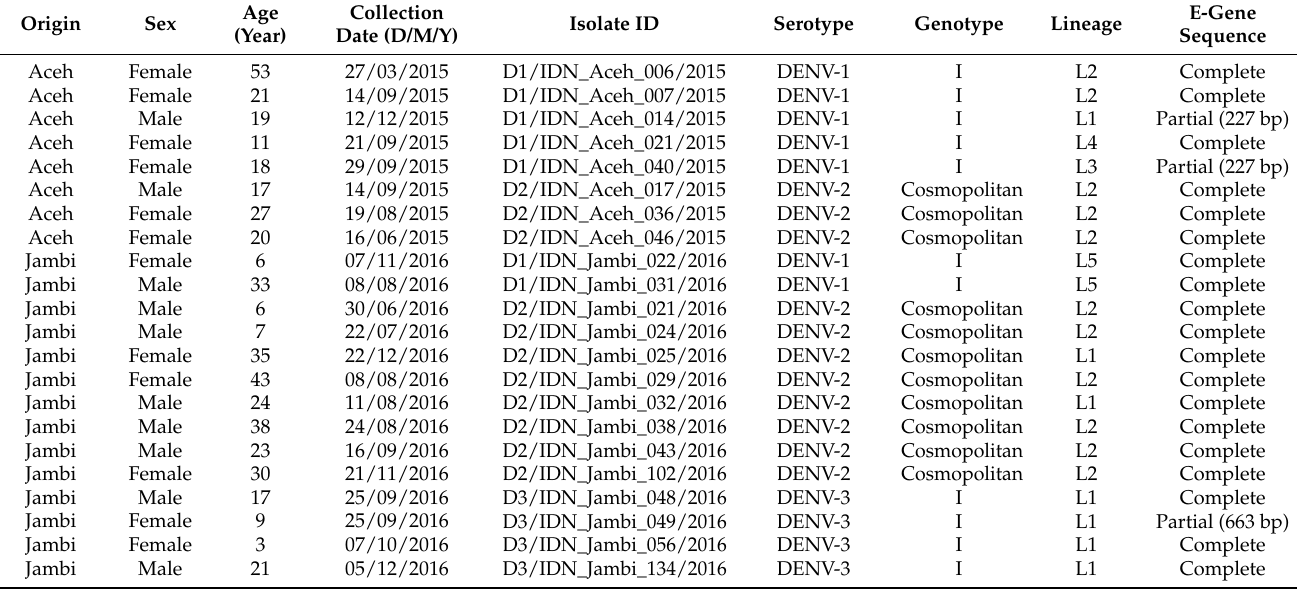
Table 2. List of DENV isolates from Aceh and Jambi and their phylogenetic